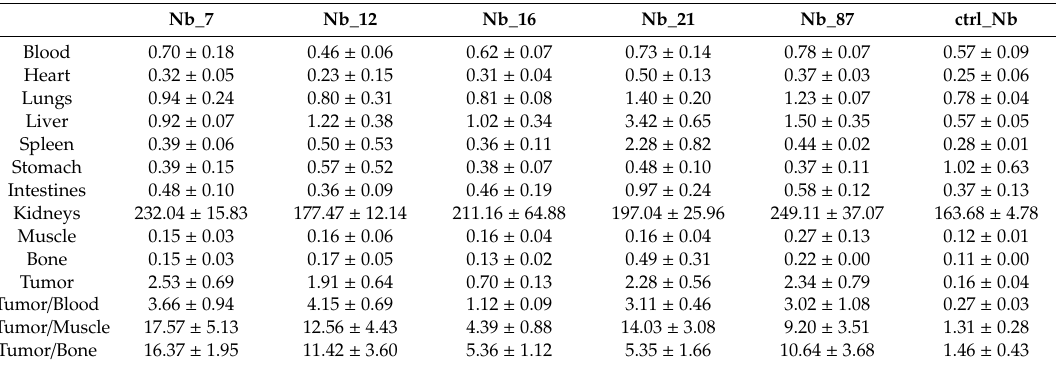
Values are expressed as %IA/g and presented as mean ± standard deviation.